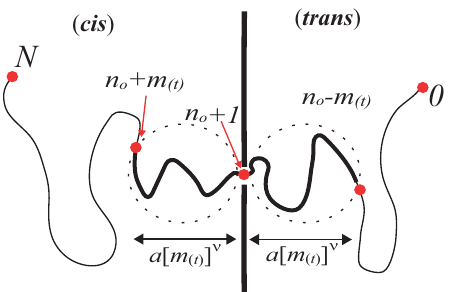
Figure 1. Illustration of a translocating polymer and the transport operation ( ∆ n = 1) to measure the stress relaxation associated with the tension propagation. The translocation coordinate is defined as the monomer label n ( t ) at the pore, which counts the number of monomers already in the trans side at time t in analogy to the reaction coordinate in chemical reaction process